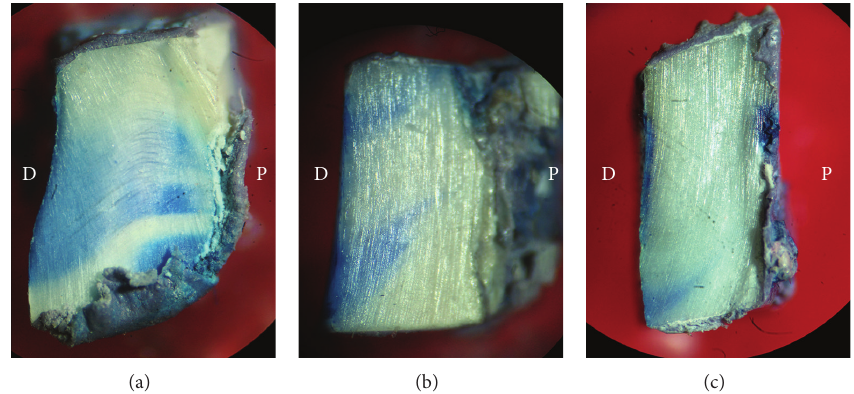
Figure 3: Dye penetration test. D: dentin surface side; P: pulpal side. (a) Control group (C), (b) laser only (L − ), and (c) the laser plus nanohydroxyapatite paste (L+). The (C) group shows a full length dye penetration while for the (L+) group the dye is confined mainly to the surface with very slight dye penetration.